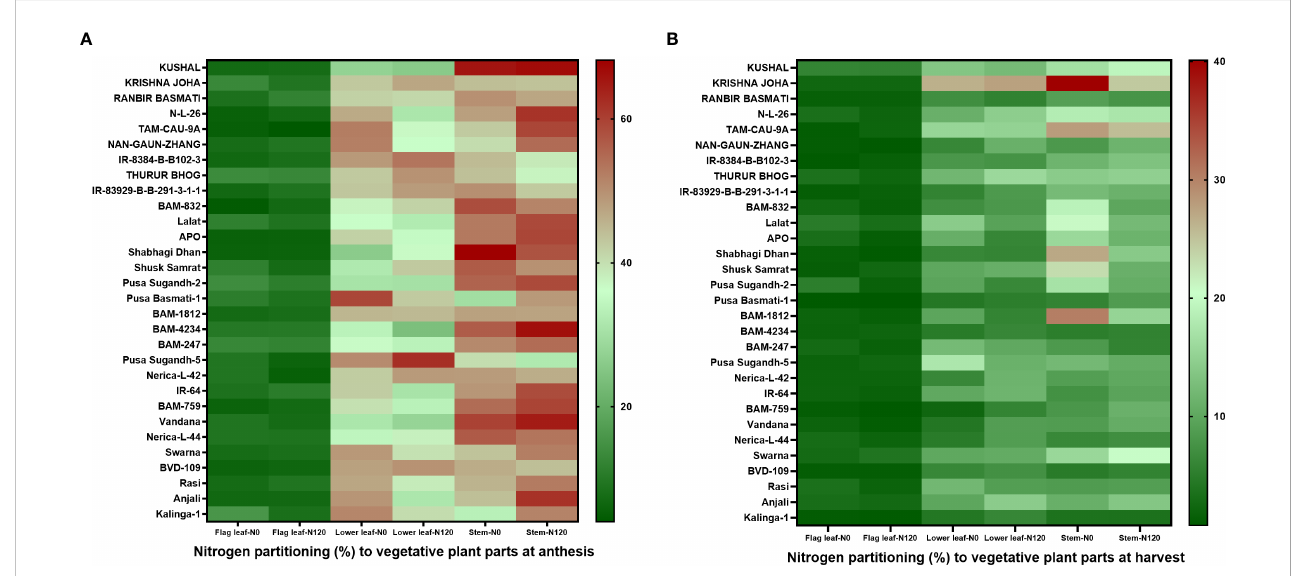
FIGURE 7 Effect of nitrogen de fi cient (0 kg ha-1 fertilizer N: N0) and nitrogen suf fi cient (120 kg ha-1 fertilizer N: N120) fi eld conditions on nitrogen partitioning to vegetative plant parts ( fl ag leaf, lower leaf, and stem) at (A) anthesis stage and at (B) harvest stage in fi eld- grown diverse rice genotypes during the 2019- kharif season. Values presented are Mean±SE with three